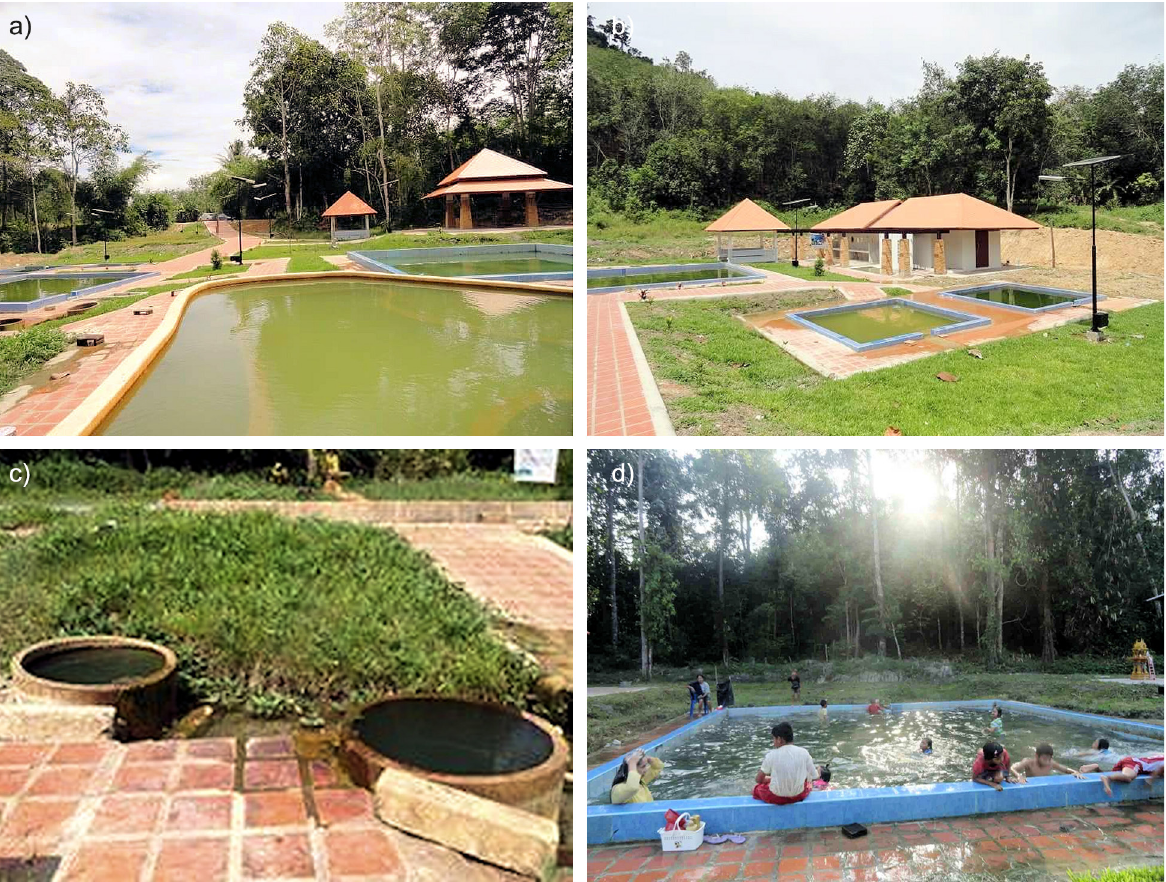
Fig. 8. Khao Daeng Hot Spring.